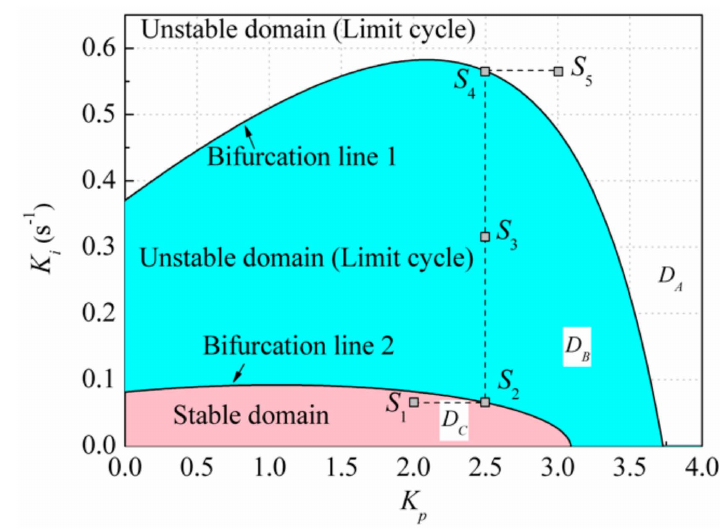
Figure 35. Stable domain and bifurcation lines of an HTGS with an upstream surge tank and an SCTT. Reproduced with permission from [51], Elsevier, 2017.